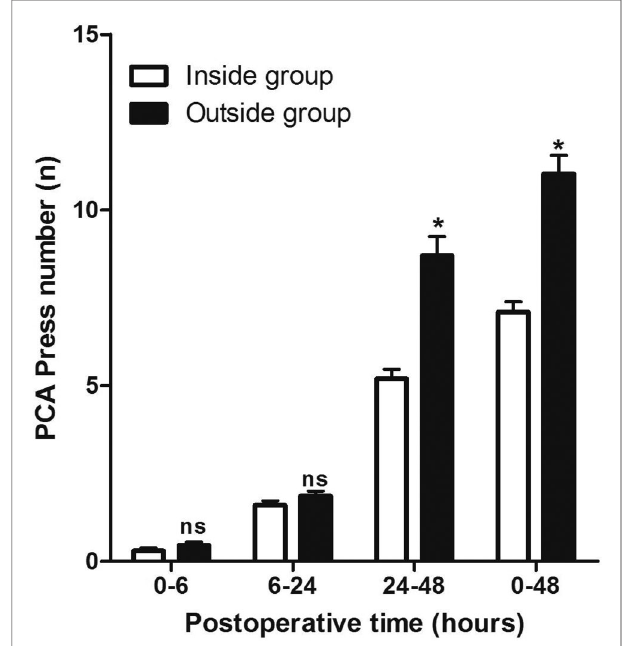
FIGURE 2 | Comparison of patient-controlled analgesia press number at different postoperative times between two groups. Compared with the Inside group, ns p >0.05 and * p